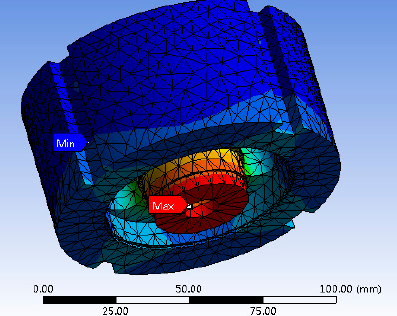
Figure 9. Displacement cloud image.